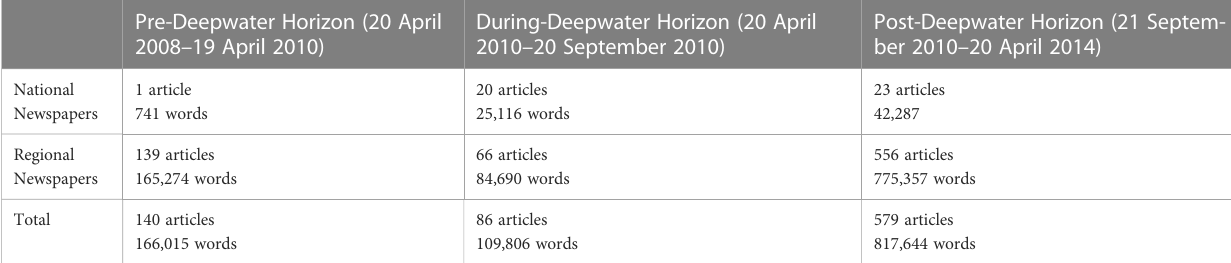
TABLE 1 DHORN text and word count by time span and level (calculated using #LancsBox 6.0).